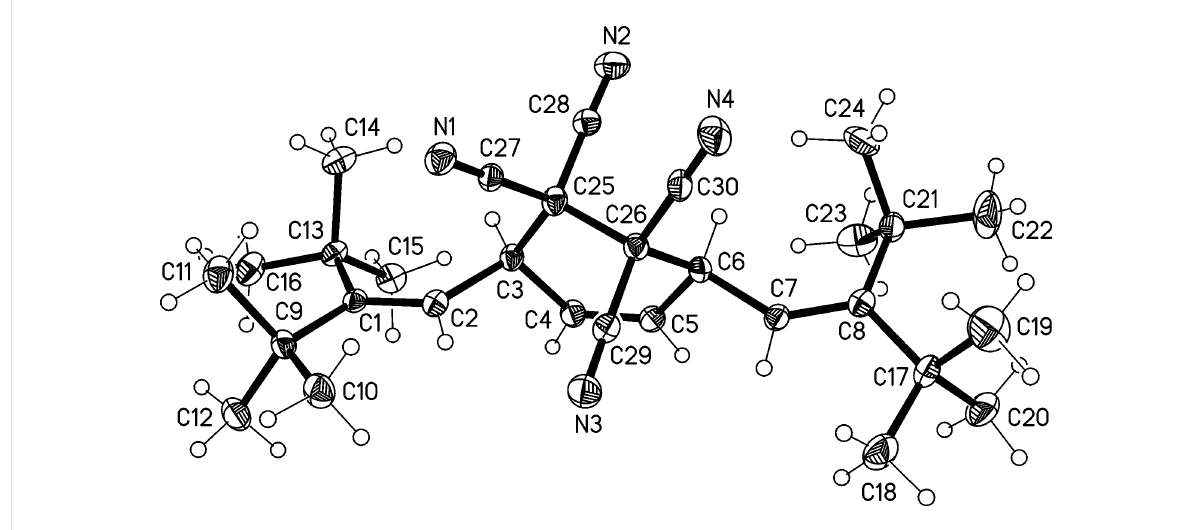
Figure 5: The structure of compound 43 in the crystal. Only one of two independent molecules is shown. Ellipsoids correspond to 30% probability levels.